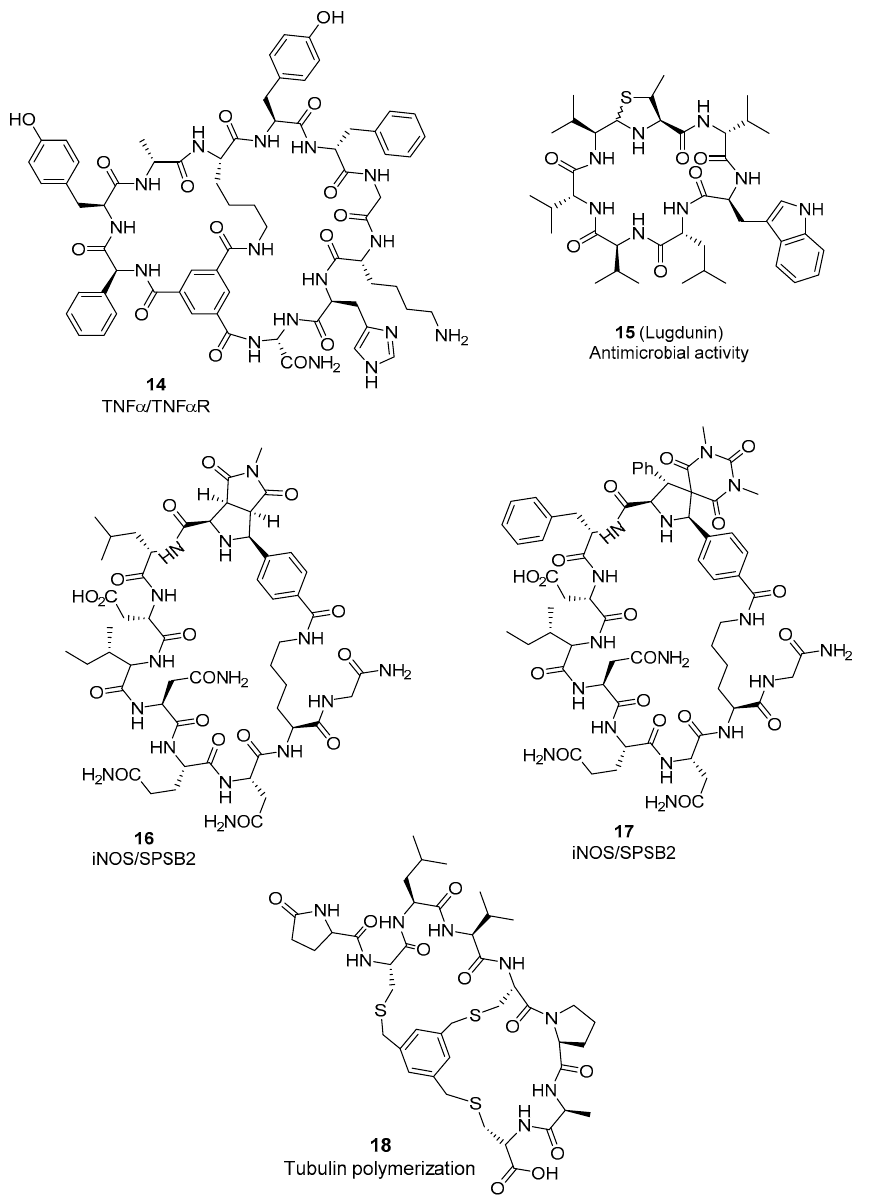
Figure 4. Selected components of totally synthetic macrocyclic peptide libraries with PPI disrupting properties.